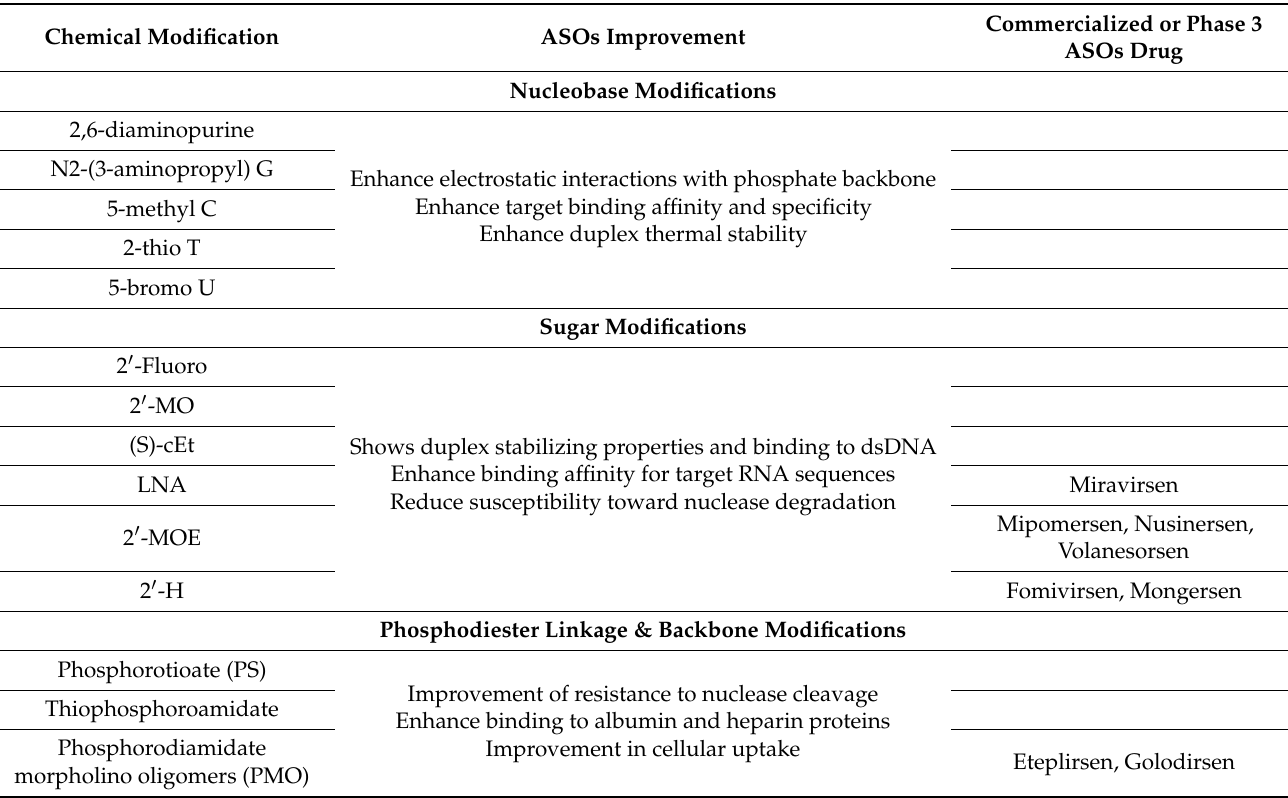
Table 1. Antisense oligonucleotide modifications and improved activities for clinical